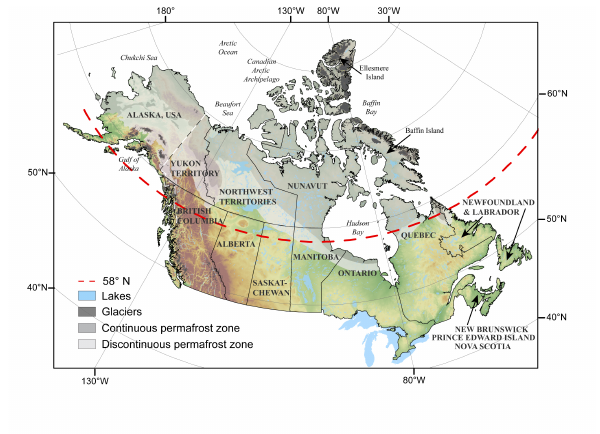
Fig. 1. Canada with provincial and territorial boundaries and the state of Alaska (USA), highlighting the area above 58 ◦ N used for this study. Also shown are areas of permafrost and glacier.